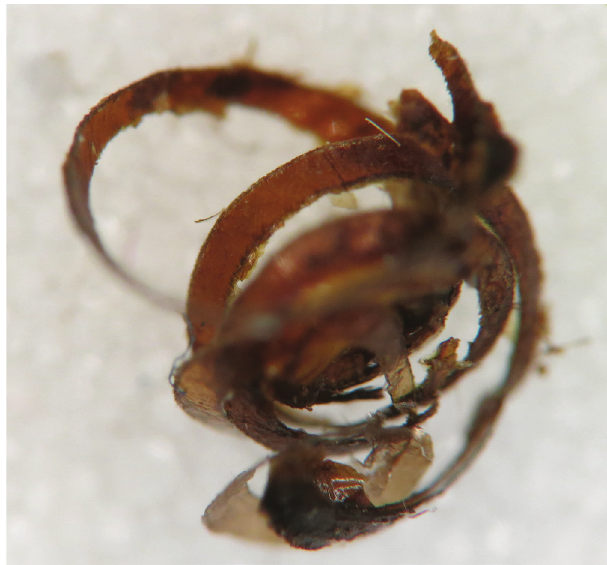
Figure 4. Heinrichiella obscura comb. n., spiral cut from apex of cocoon